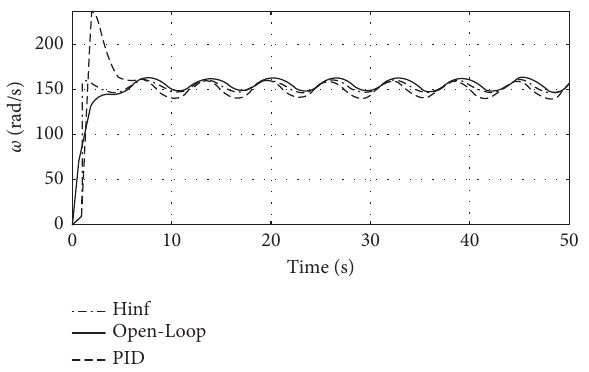
Figure 4: Te angular velocity of the frst order system for τ � 1s for sinusoidal